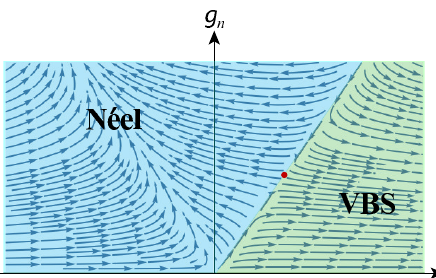
Figure 1: The coupled RG flow of λ and g based on Eq. 11. A new fixed point n 4 ε n ( λ ∗ , g ∗ ) = ( 2 ε n π , π ) is found, which separates two phases: the phase where n λ → + ∞ is the VBS phase, and the phase with ( λ , g ) → ( −∞ , + ∞ ) is the long n range Néel order at the 1 d boundary. But on the Néel order side of the phase dia- gram, the RG flow is complicated and nonmonotonic, hence it may take a long RG scale, or a large system size to finally reveal the true long range